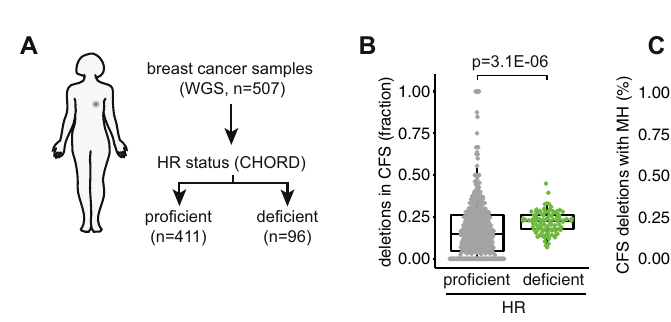
(larger or equal to 2bp) at the breakpoints were plotted in panel C . Box plots depict the mean (center line), 25 th and 75 th percentiles (box boundaries), and the largest values no more than 1.5* the interquartile range (whiskers). Statistical analysis was done using an FDR-corrected two-sided Wilcox test. D Analysis of deletions within CFS with or without MH as a percentage of total deletionsin 507 breast cancers were